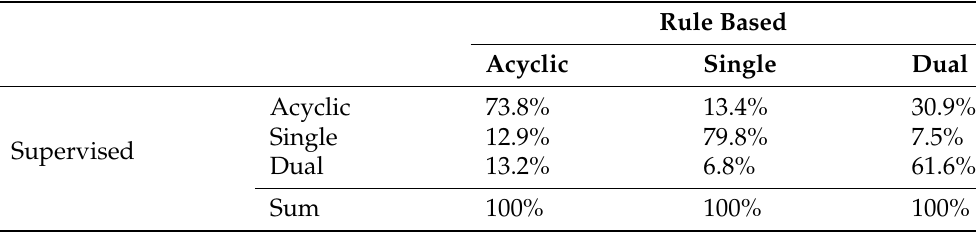
Figure 21. Comparing the average amplitude of the ACF types classified with the rule-based and supervised classification. Table 5. Comparing the classification result from different approaches in a comparison matrix with values normalized to the sum of the pixels in each category from rule based classification.